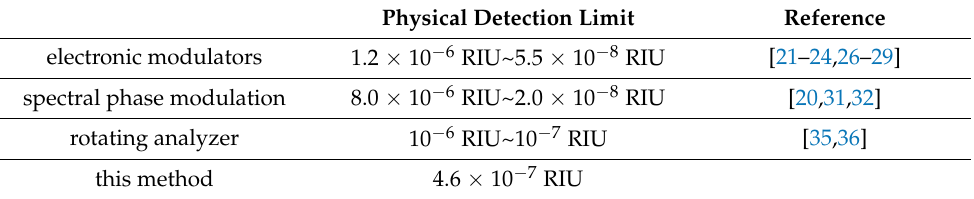
Table 1. The physical detection limit achieved by other approaches and the proposed SPR